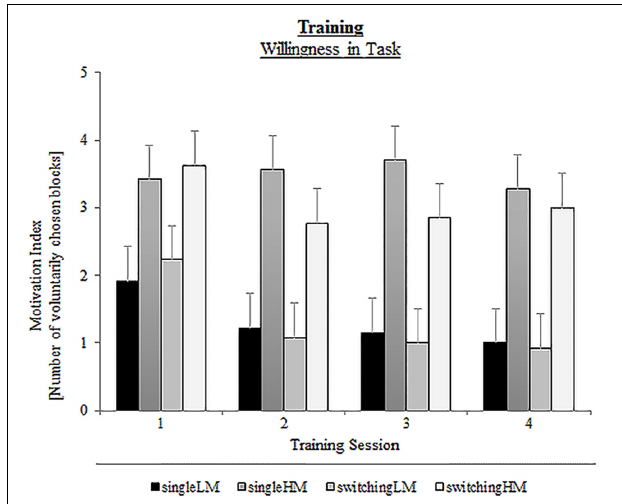
FIGURE 5 | Motivation index (number of voluntarily chosen blocks) as a function of Training Group (single-LM, single-HM, switching-LM, switching-HM) and Training Session (1,2,3,4). Error bars depict standard errors (SE) based on the group x session interaction comparing group conditions of the respective mixed ANOVA according to Jarmasz and Hollands (2009). Note that the selected variance estimators are not suited to compare session conditions.